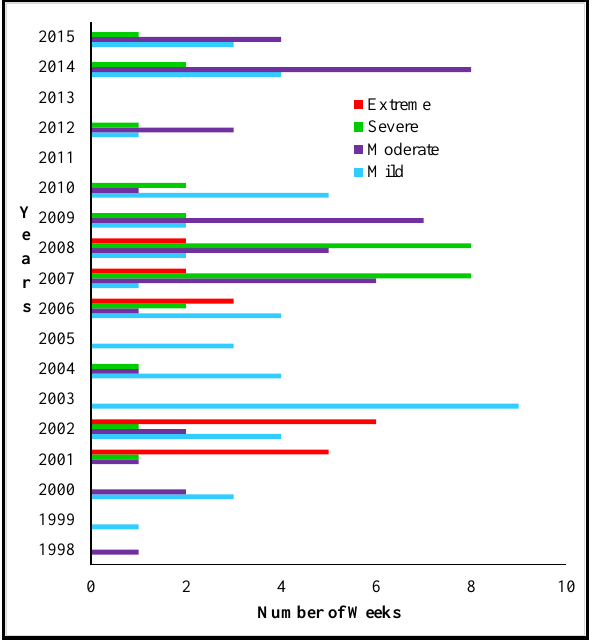
Figure 3: Number of weeks with drought severity (mild, moderate, severe and extreme) estimated by SMDI for the study